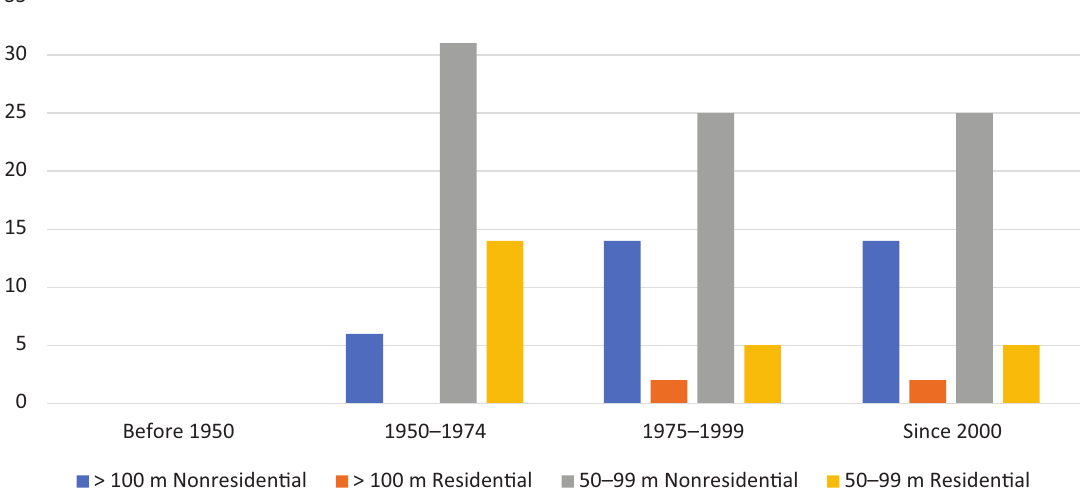
Figure 5. Construction of tall buildings (50 m and above) in Frankfurt. Sources: Author’s work based on personal observa‐ tions, Hilgenstock (2011), Wikipedia (2022e), and Zabel